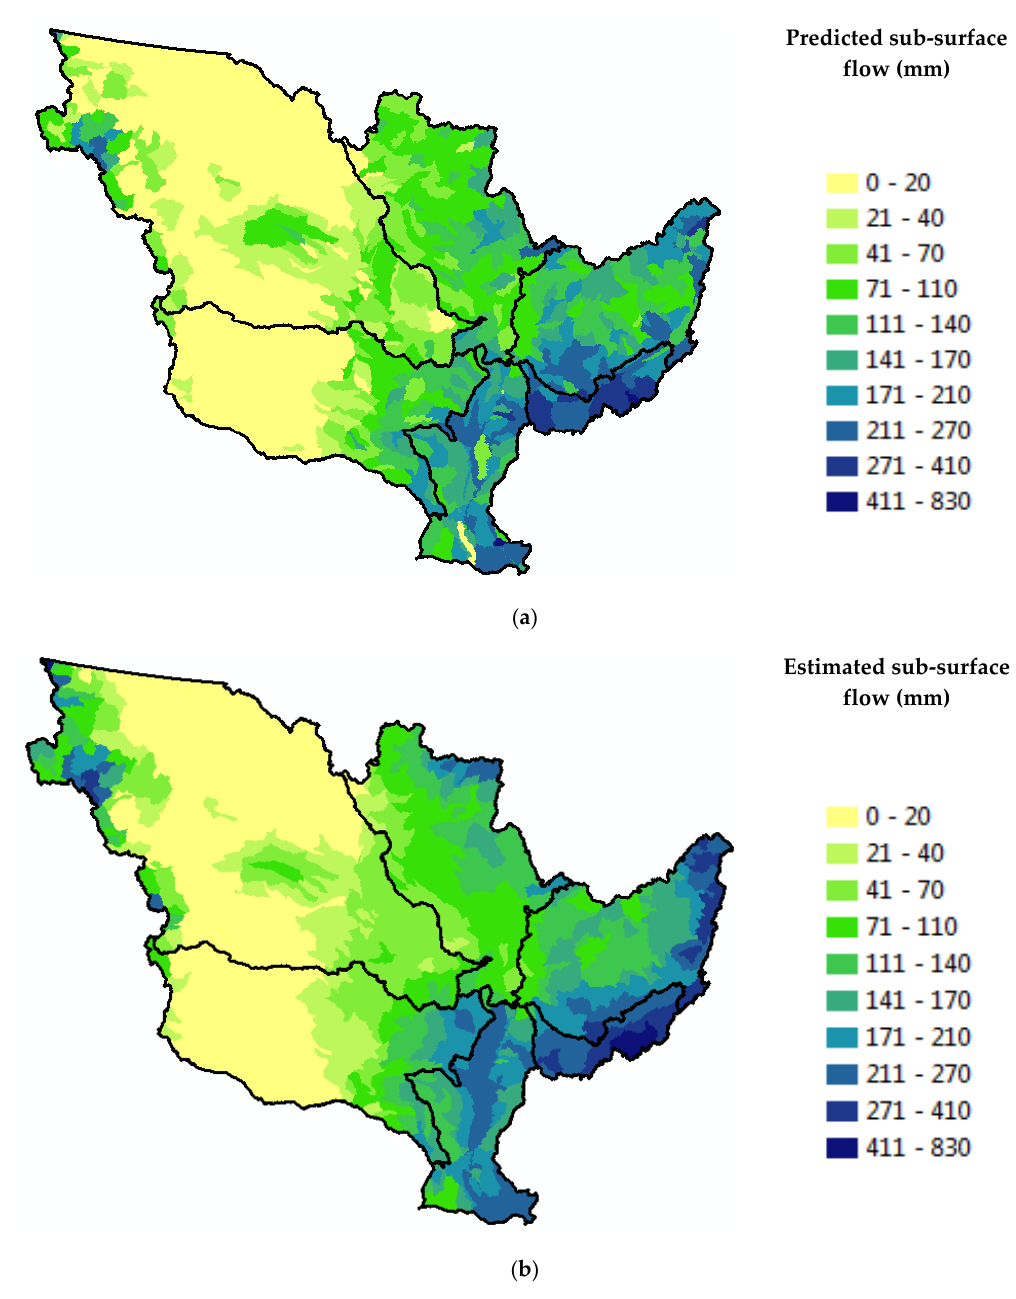
Figure 4. Comparison of sub ‐ surface flow: ( a ) Model predictions; ( b ) Calibration target.